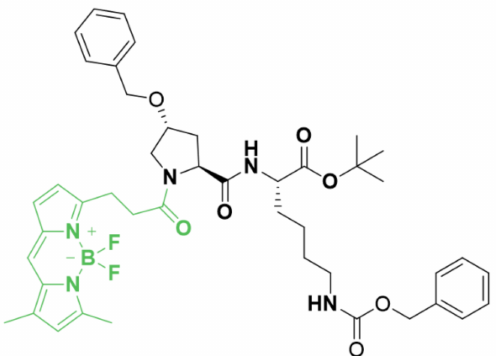
Figure 1. Chemical structure of LightSpot ® -FL-1: a peptidic P-gp ligand (black) conjugated to the BODIPY-FL fluorophore